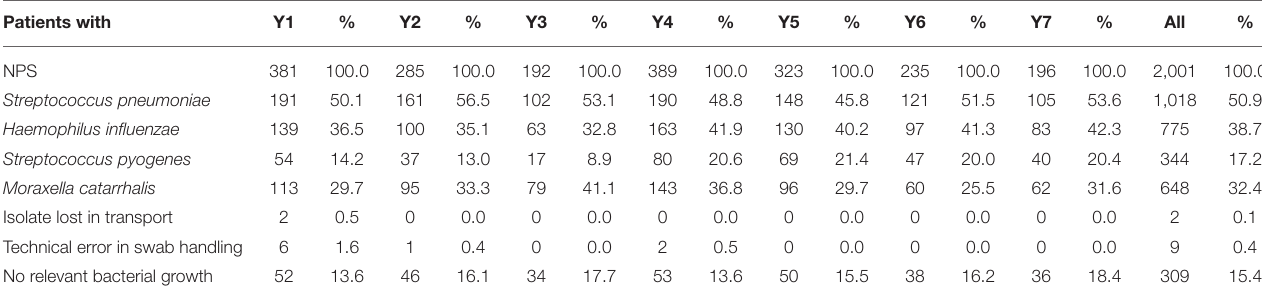
TABLE 3 | Numbers of patients with relevant bacteria in NPS. Patients with